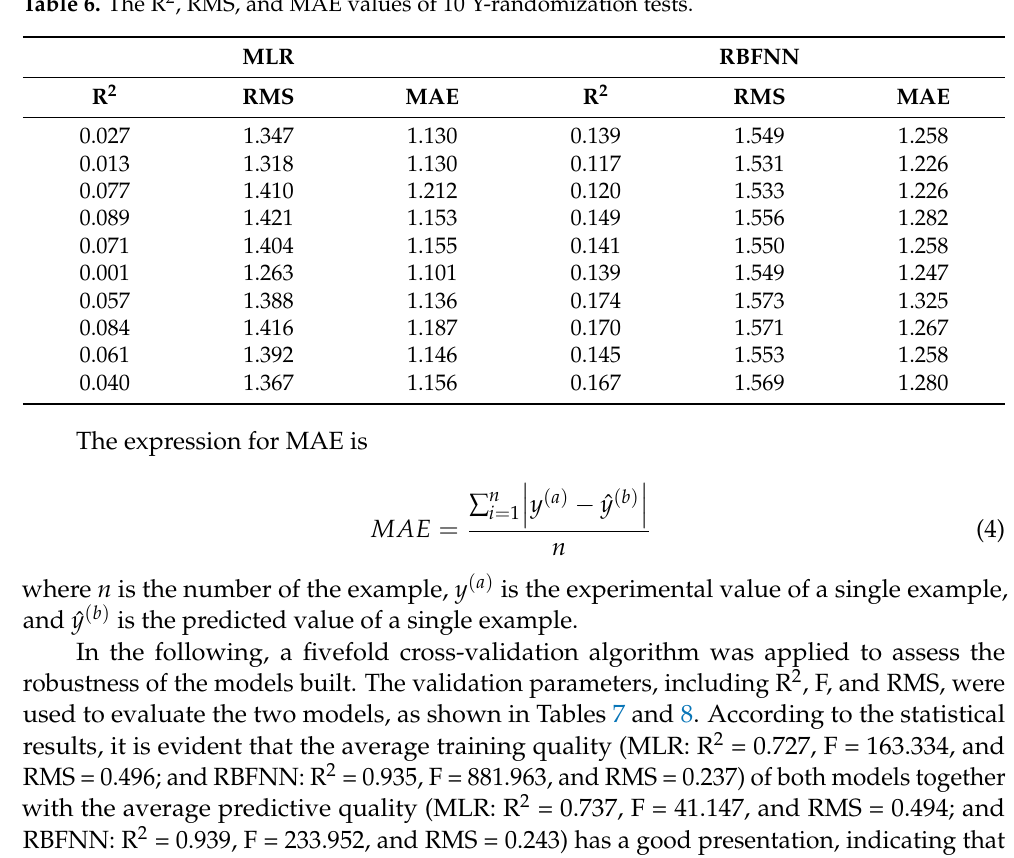
Table 6. The R 2 , RMS, and MAE values of 10 Y-randomization tests.